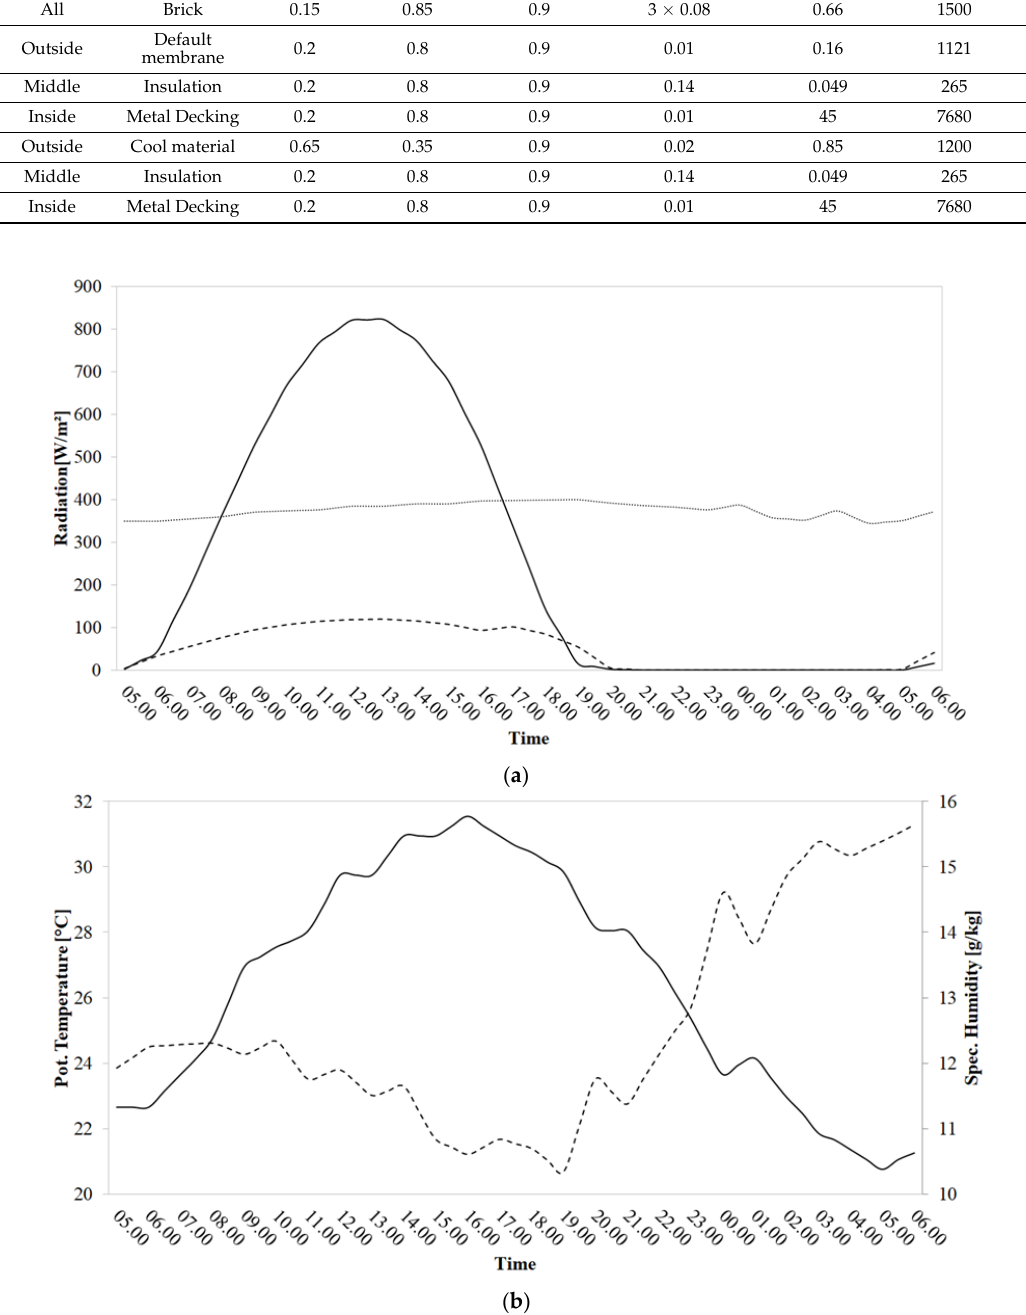
Figure 3. Meteorological boundary conditions for the proof-of-concept simulation depicting direct shortwave (black line), diffuse shortwave (dashed line), and longwave radiation (dotted line) ( a ) as well as potential air temperature (black line) and specific air humidity (dashed line) ( b ).